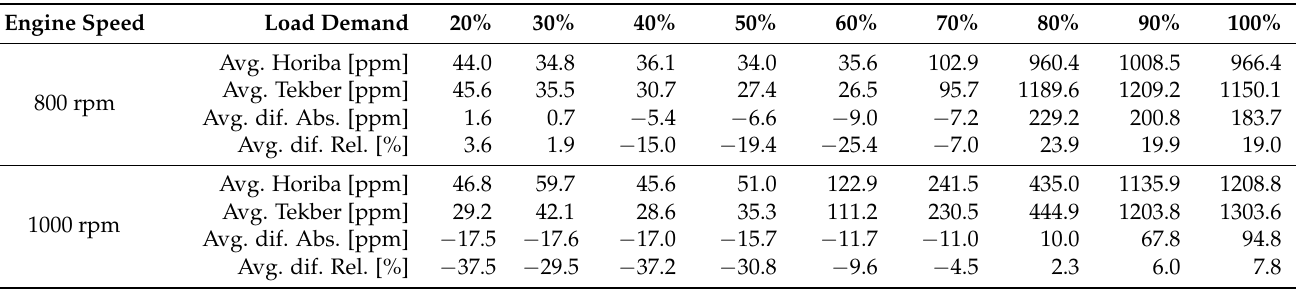
Table A7. Summary of the average concentration and differences between Horiba and Tekber equipment with EGR